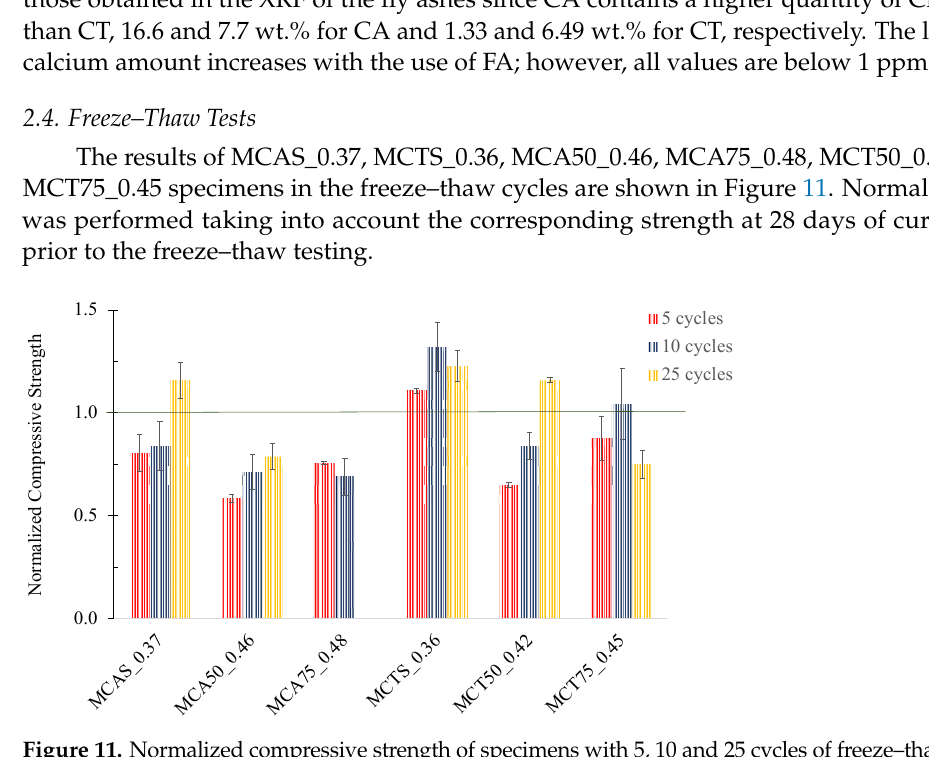
Figure 11. Normalized compressive strength of specimens with 5, 10 and 25 cycles of freeze–thaw tests.